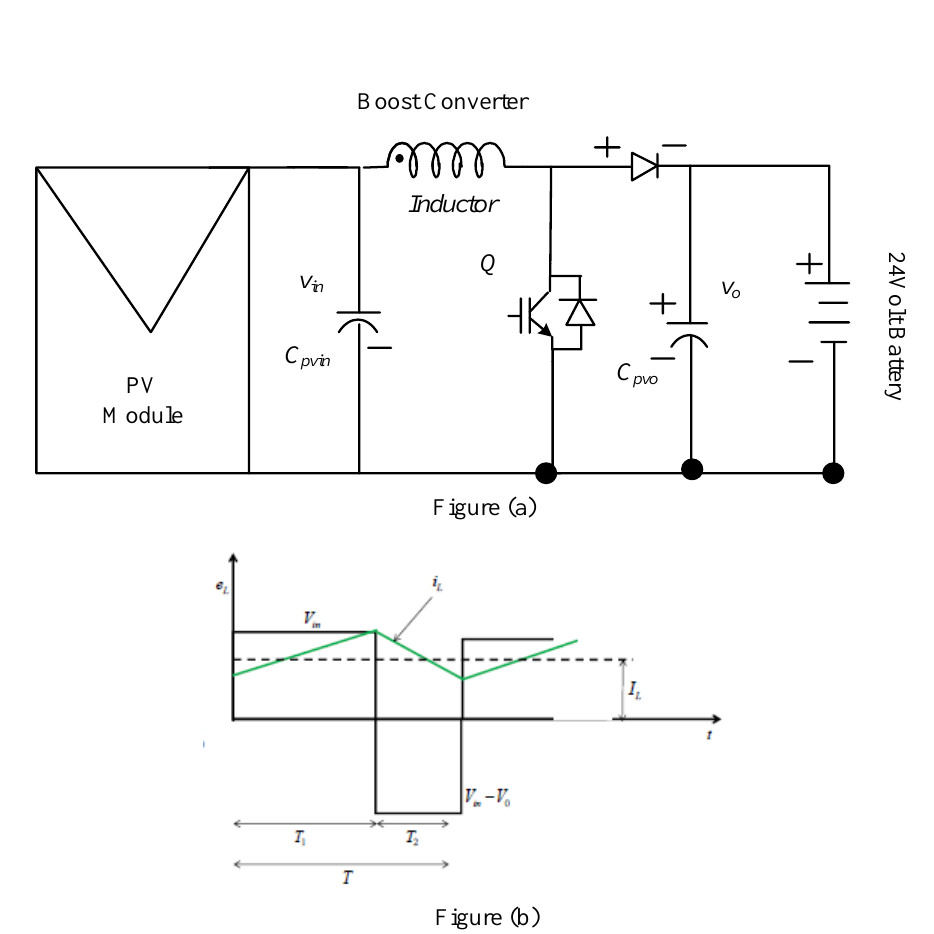
Figure 3. (a) a schematic diagram of dc to dc steps up converter and (b) shows the inductor current